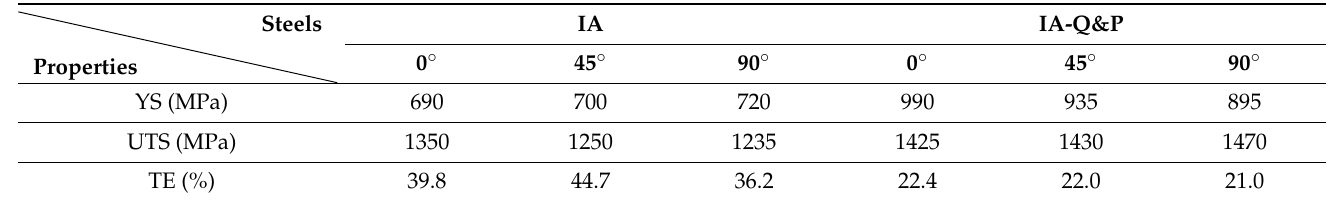
Figure 3. ( a ) Engineering stress–strain curves, ( b ) true stress–strain curves, and ( c ) work hardening rate curves of the steel processed by IA and IA-Q&P heat treatments along the 0°, 45°, and 90° directions with respect to the rolling direction. Table 1. Mechanical properties of the IA steel and IA-Q&P steel along three different directions (0°, 45°, 90°).